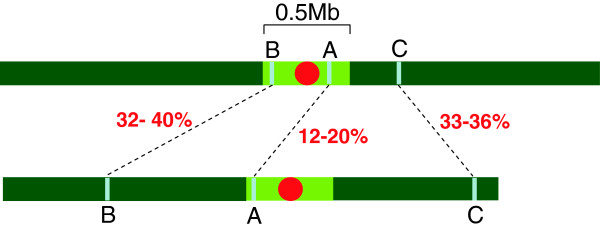
Diagram of two plant chromosomes with 3 types of paralogues (A, B and C) which differ in their chromosomal location. Paralogues A, B, and C are marked with blue bars. The percentages of non-conserved disorder between paralogues are shown. The centromere is drawn in red within a centromeric region of 0.5 Mb, shown in light green. The percentage values correspond to 1/8 and 2/10 A-type proteins, 189/463 and 161/505 B-type proteins, and 1419/4056 and 1479/4362 C-type proteins of A. thaliana and O. sativa, respectively.